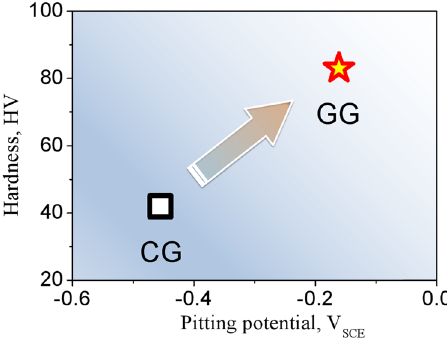
Fig. 9 Ashby pro fi le. Ashby pro fi le showing that hardness and pitting corrosion resistance of Al – Mn alloy improved simultaneously by the gradient design of microstructure and chemistry.